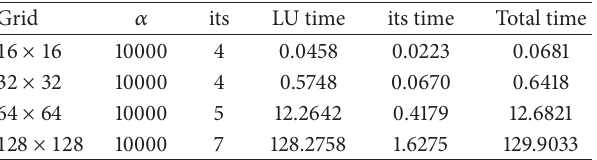
Table 12: Preconditioned GMRES(20) on steady Oseen problems with different grid sizes (uniform grids), viscosity V = 0.001